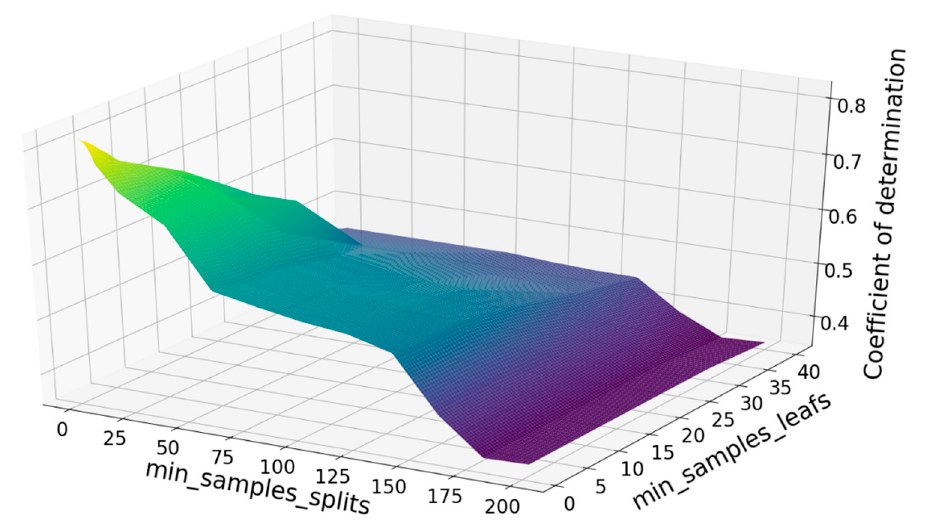
Figure 19. R 2 change curve of the Random Forest (RF) model with parameters min_samples_split and min_samples_leaf.